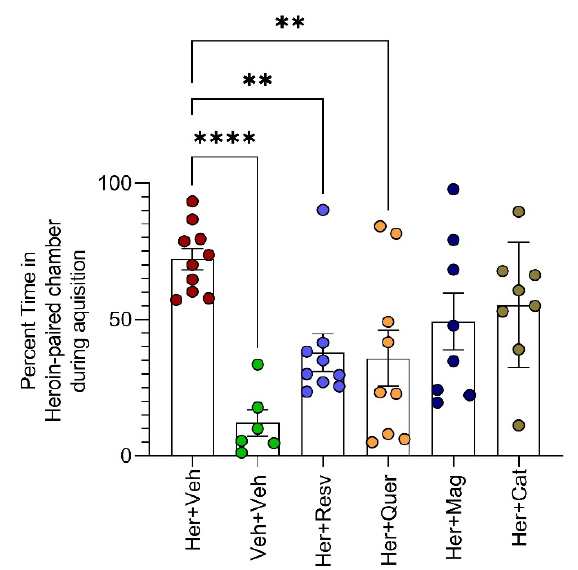
Figure 2. Heroin CPP acquisition is blocked by resveratrol and